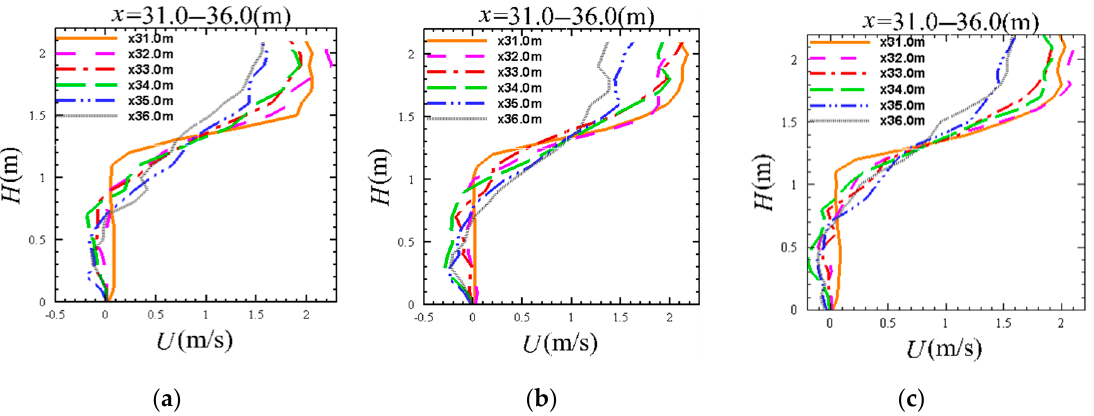
Figure 17. Longitudinal velocity distribution in the back vortex flow field when the porosity is 0.5, 0.25, and 0.125 and x = 31.0–36.0 m. ( a ) n w = 0.5; ( b ) n w = 0.25; ( c ) n w = 0.125.